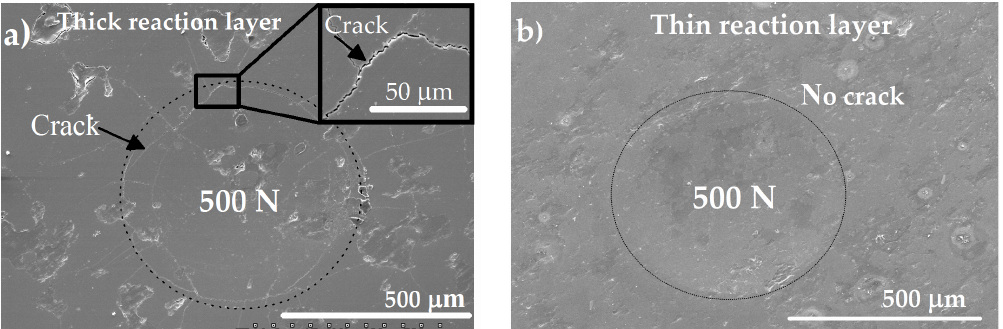
Figure 4. SEM images showing the impressions of ball indentations on the surface of thick after applying a load of 500 N ( a ), and thin reaction layers after applying a load of 500 N ( b ). Reproduced from [101] with permission from Elsevier.